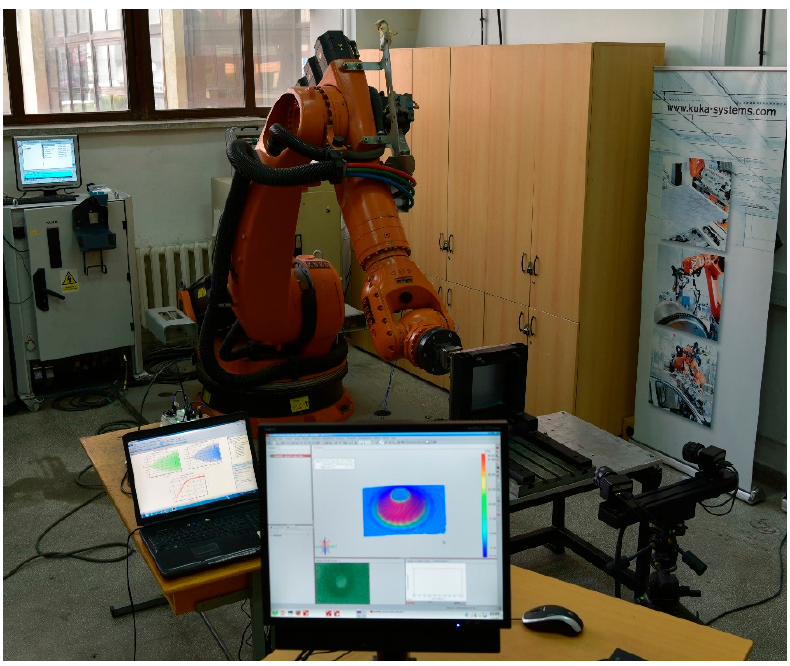
Figure 4. Experimental layout used for single point incremental forming of tailored welded blanks.